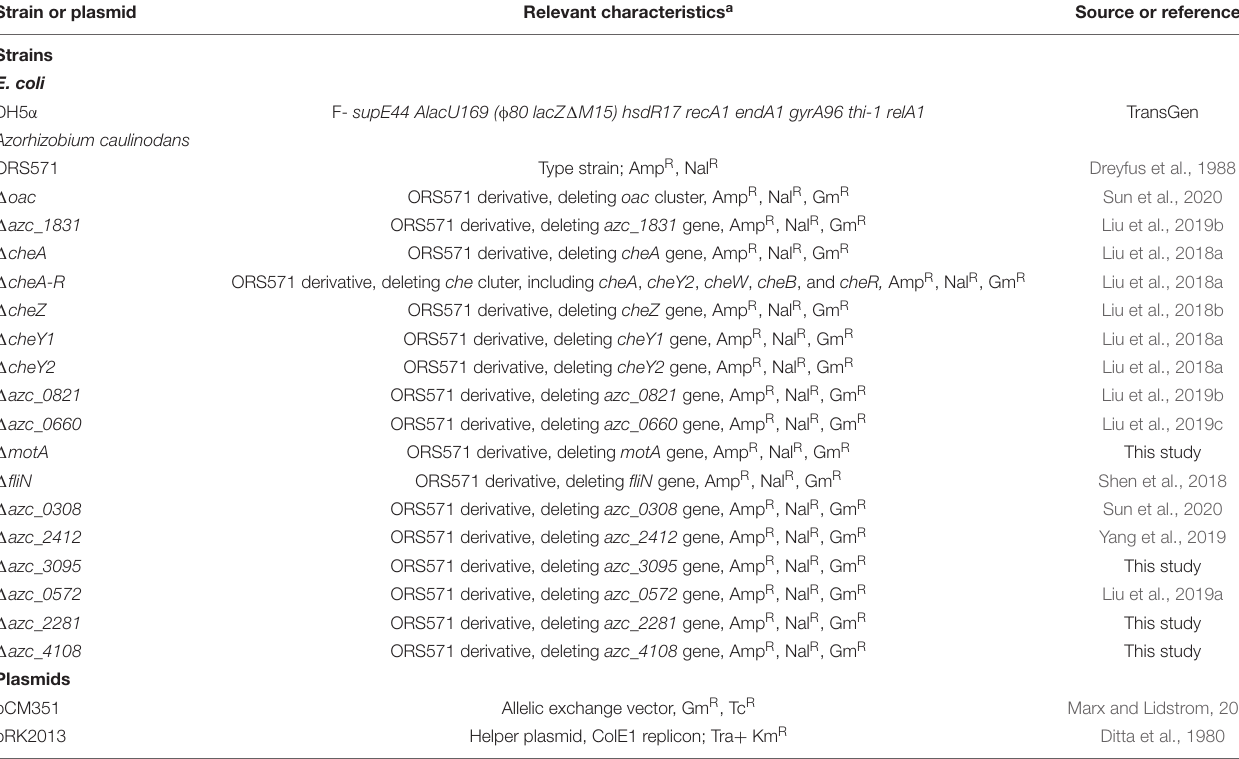
TABLE 1 | Bacteria strains and plasmids used in this study.